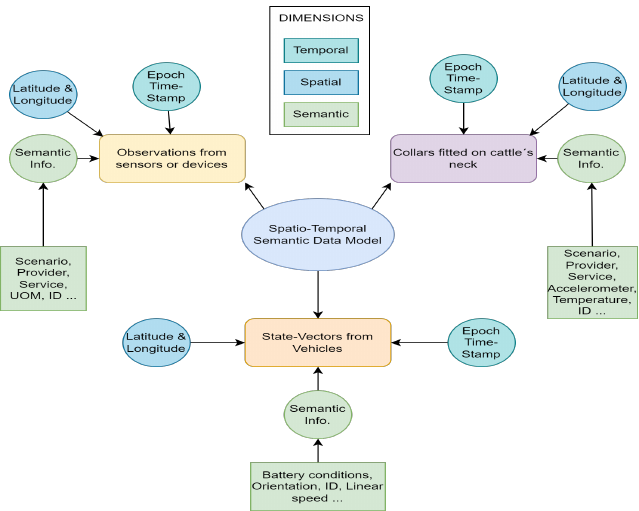
Figure 2. Information associated with each dimension in the modeling